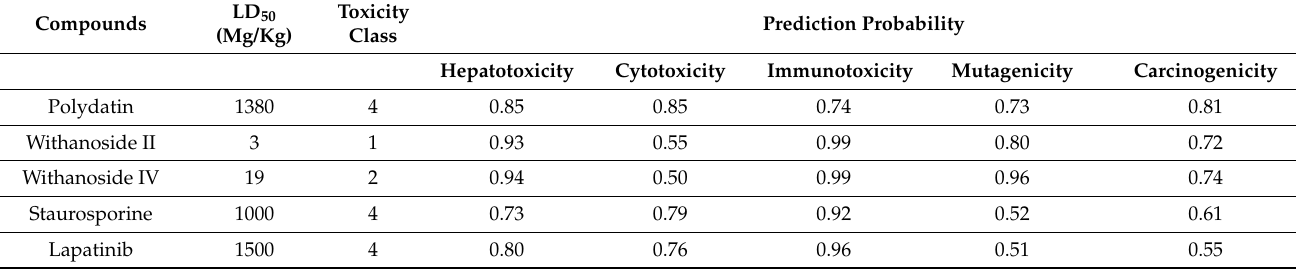
Table 4. Toxicity analysis of natural compounds and